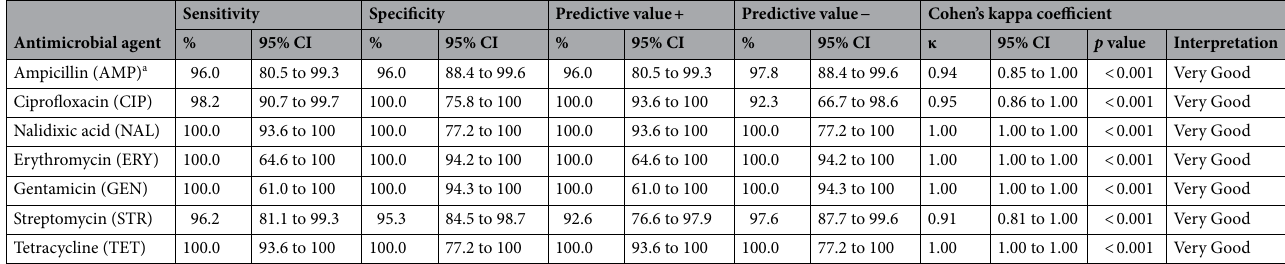
Table 1. Concordance tests between phenotypic antimicrobial susceptibility testing and WGS-based predicted antimicrobial resistance. a Presence of bla OXA-61 -like gene with T at the promoter region (57 bp upstream of the start codon) and/or presence of bla OXA-184